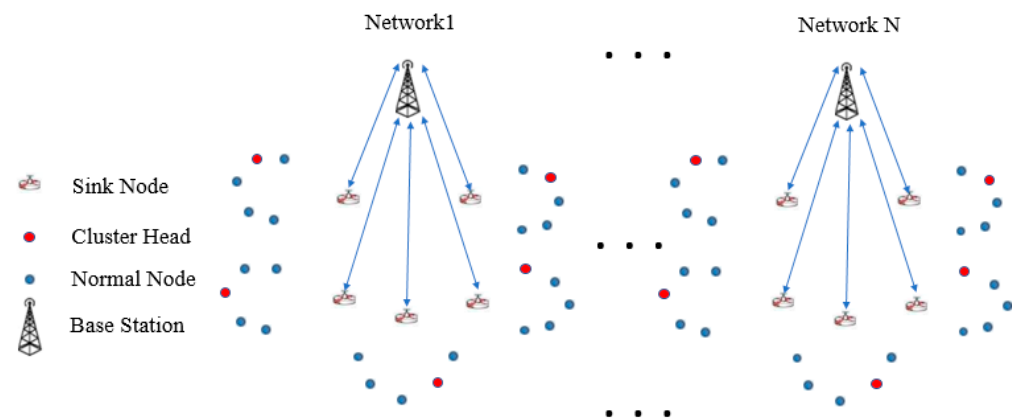
Figure 4. Illustration of the LEDCHE-WSN architecture.